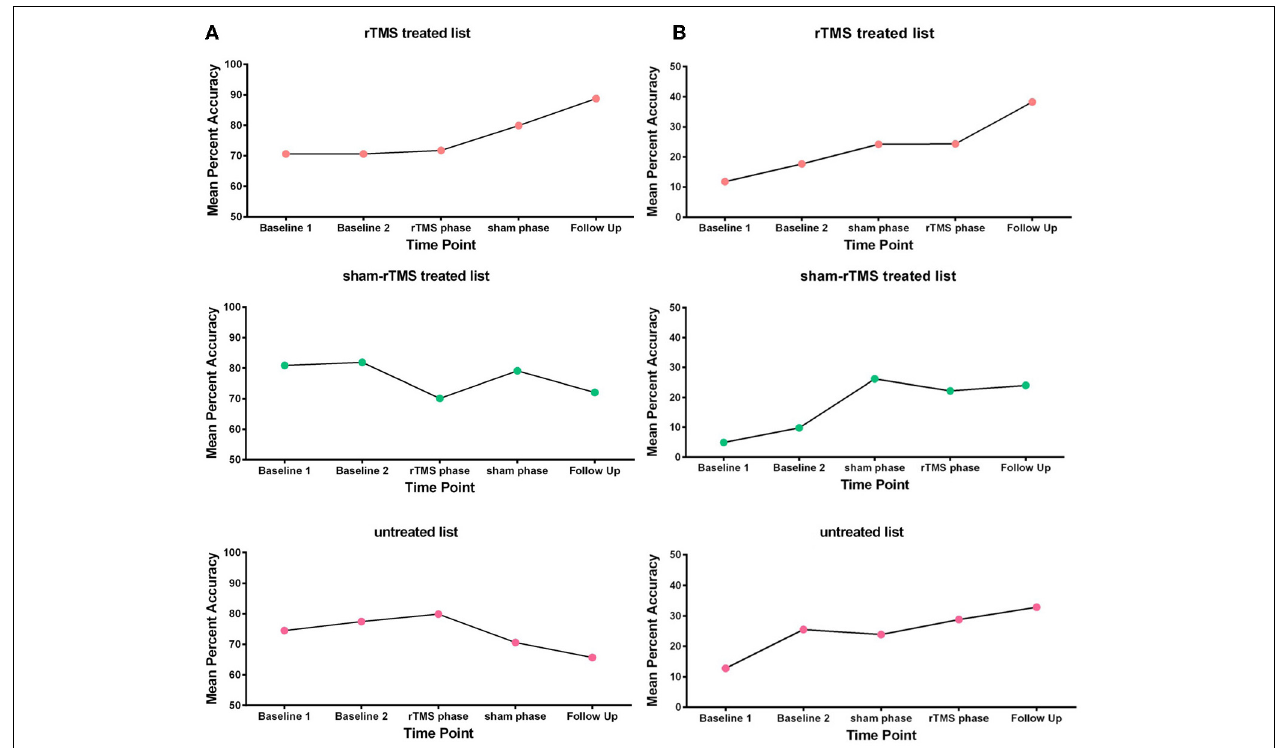
FIGURE 3 | Mean percent accuracy of phrase repetition at baseline, during the treatment phases, and at the follow up session for (A) participant GOE and (B) participant